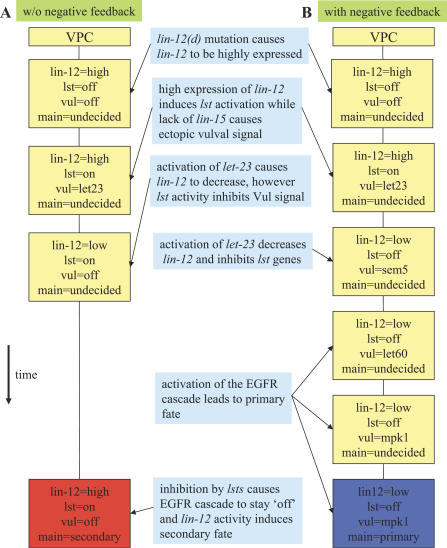
Simulation of the Model in the Absence (A) and Presence (B) of a Negative Feedback from EGFR to lst GenesEach rectangle represents a snapshot of the state of a VPC. Time flows from top to bottom and the changes in values of components represent the evolvement of simulation. Both simulations are according to the mutation lin-12(gf);lin-15(o). Both simulations start with lin-12 activated (according to lin-12(gf) mutation), and let-23 activated (according to lin-15(o), no inhibition from hyp-7).(A) lin-12 activates lst. Activation of let-23 inhibits lin-12; however, activation of lst prevents activation of sem-5. EGFR is counteracted and the cell assumes a 2° fate (red).(B) Inhibition of let-23 on lst prevents lst activation. The EGFR pathway is fully activated and the cell assumes a 1° fate (blue).